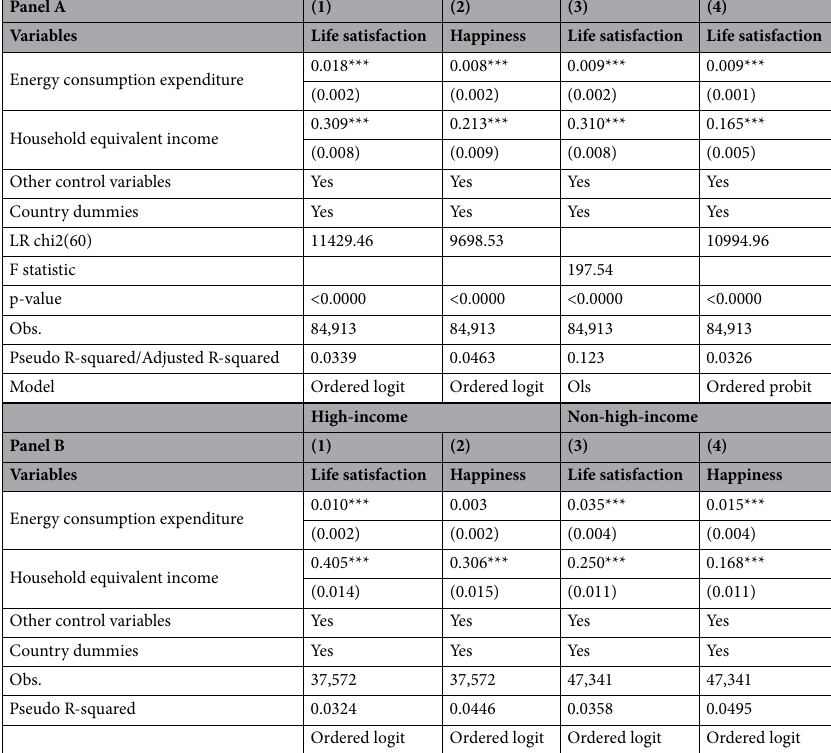
Table 2. Association between energy consumption expenditure and subjective well-being in high- and non- high-income countries. Standard errors are shown in parentheses. *** p < 0.01, ** p < 0.05, * p < 0.1. Other control variables include education attainment, age, occupational status, household status, number of children, and gender